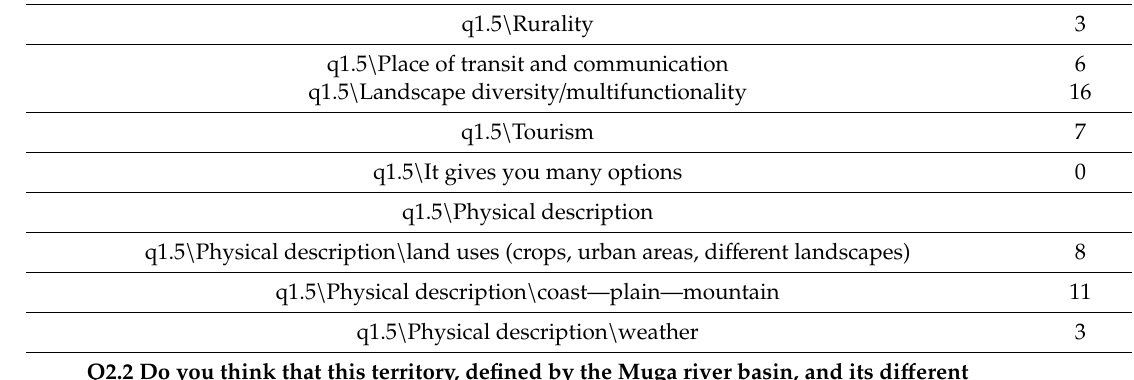
Table A2. Coding of interview responses and categories derived from the content analysis (Code structure– categories–code